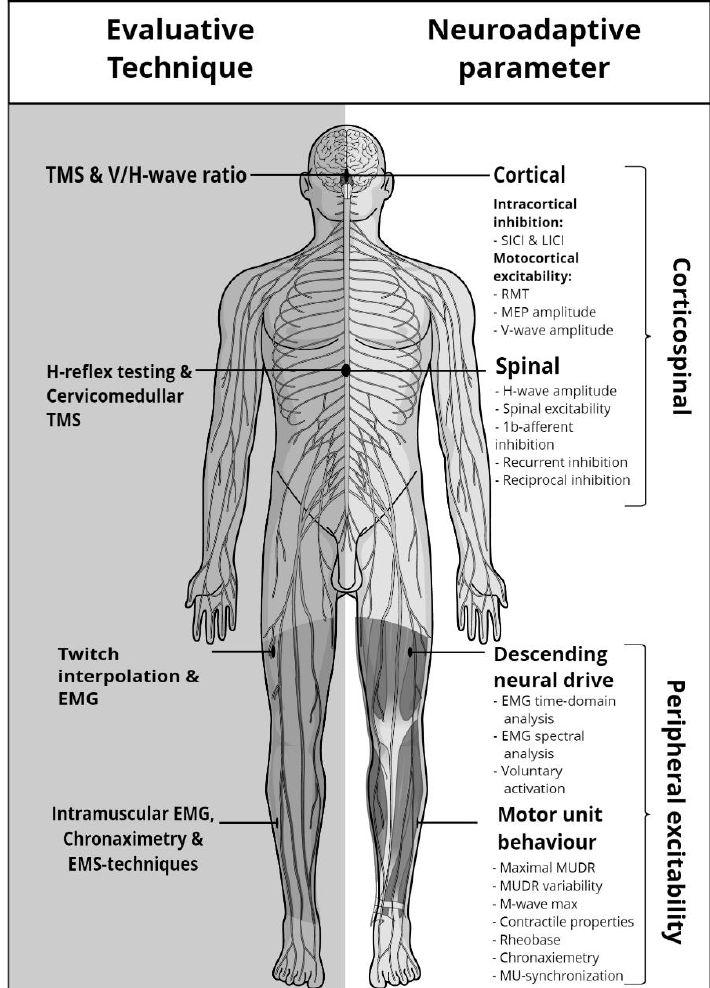
Figure 2. Potential sites of evaluations along the descending neuroaxis with corresponding tech- niques and parameters. Legend: TMS, Transcranial magnetic stimulation; V-wave, Volitional wave; H-wave, Hoffman wave; H-reflex, Hoffman reflex; EMG, Electromyography; EMS, Electrical muscle stimulation; SICI, Short-interval intracortical inhibition; LICI, Long-interval, Intracortical inhibition; RMT, Resting motor threshold; MEP, Motor-evoked potential; MUDR, Motor-unit discharge rate; M-max, Maximal elicited muscle amplitude.